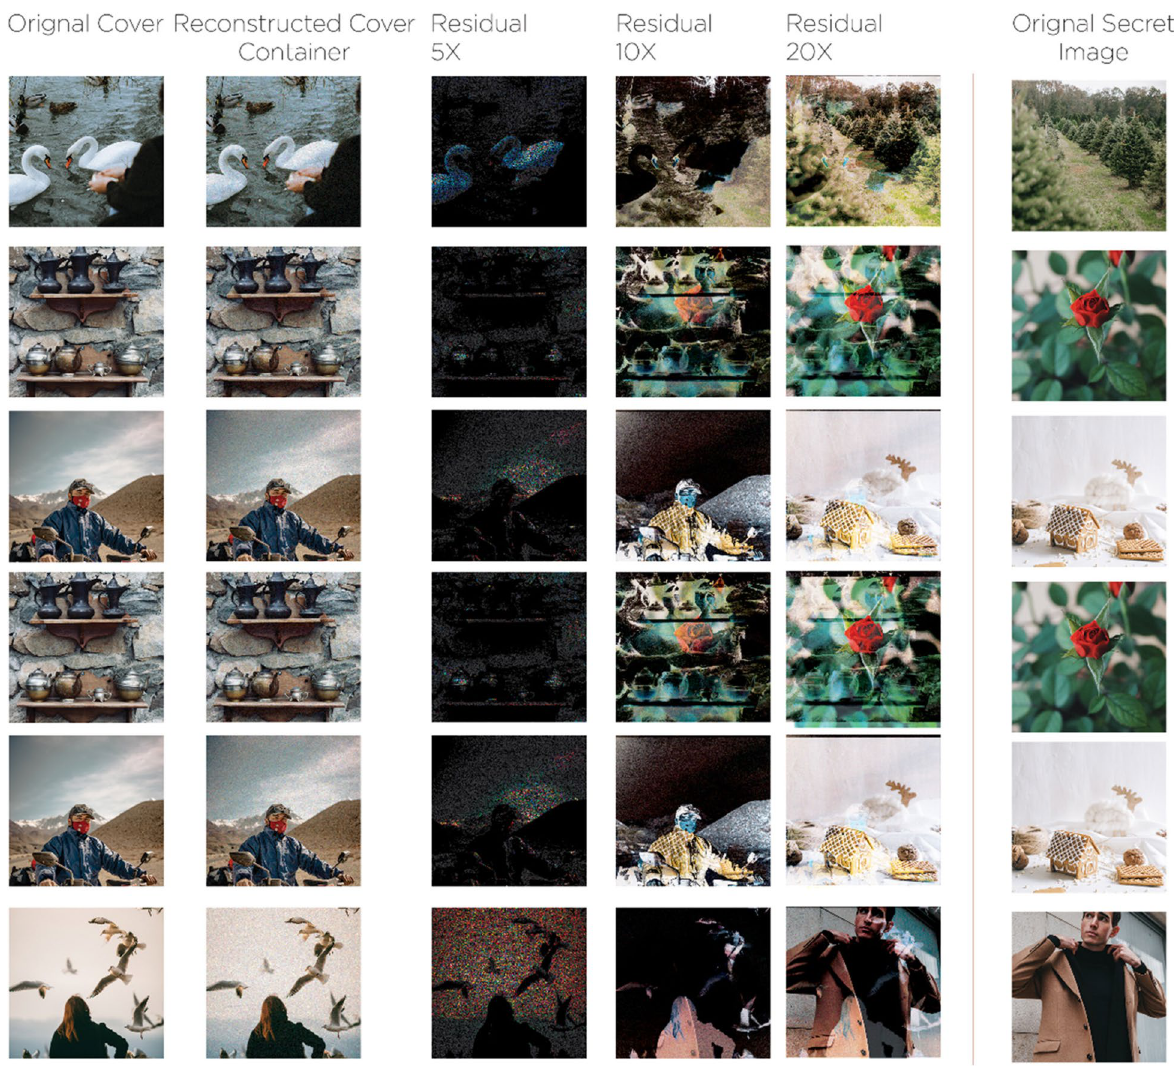
Fig. 25 A description of the residual image computation that can be achieved in case the container image substation during the original image leakage, as it shown in column 3, 4 and 5 then enhancement output can be seen in 3rd, 4th and 5th rows with enhancement rate of 5 x , 10 x and 15 x of residual